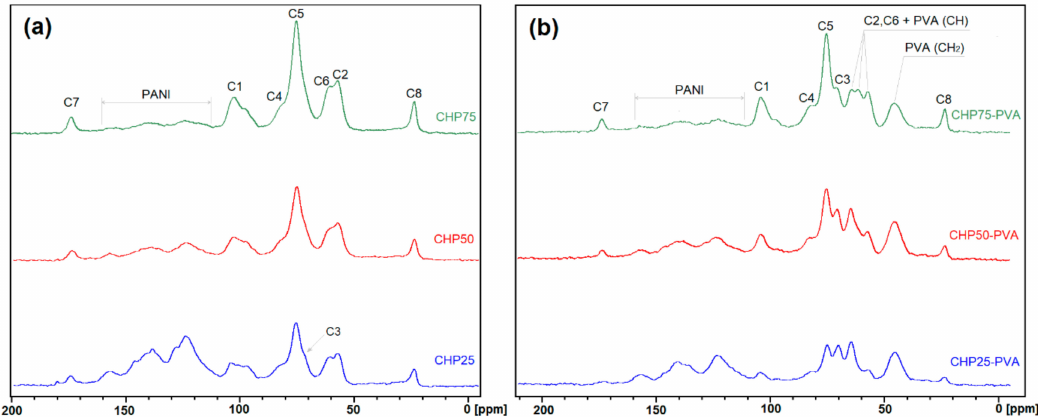
Figure 2. Solid state CP-TOSS 13 C NMR spectra of polymer composite materials at 295 K: ( a ) binary PANI–CHT composites; ( b ) ternary PANI–CHT–PVA composites. Spectral acquisition at the MAS frequency of 7.5 kHz with a 2 s recycle delay with 1 ms of cross-polarization.